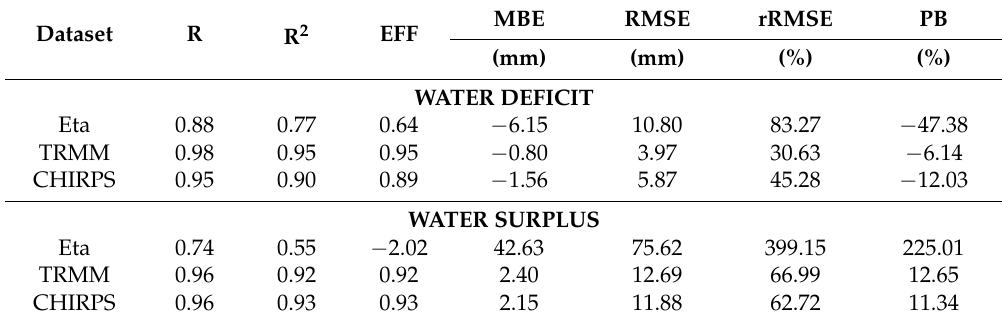
Table 6. Coefficients of correlation (R), determination (R 2 ) and Nash-Sutcliffe efficiency (EFF),